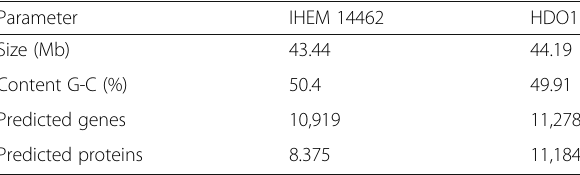
Table 5 Genomic features comparison between HDO1 strain and IHEM 14462 strain [22]